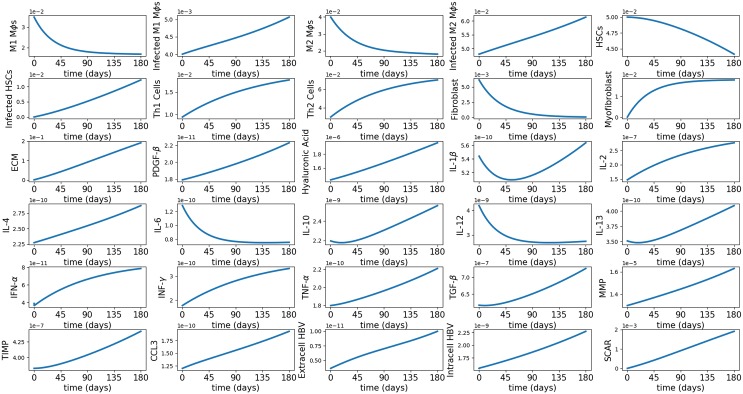
Simulation of all the average densities/concentrations of the variables for Model (1)–(28) over a period of 180 days.